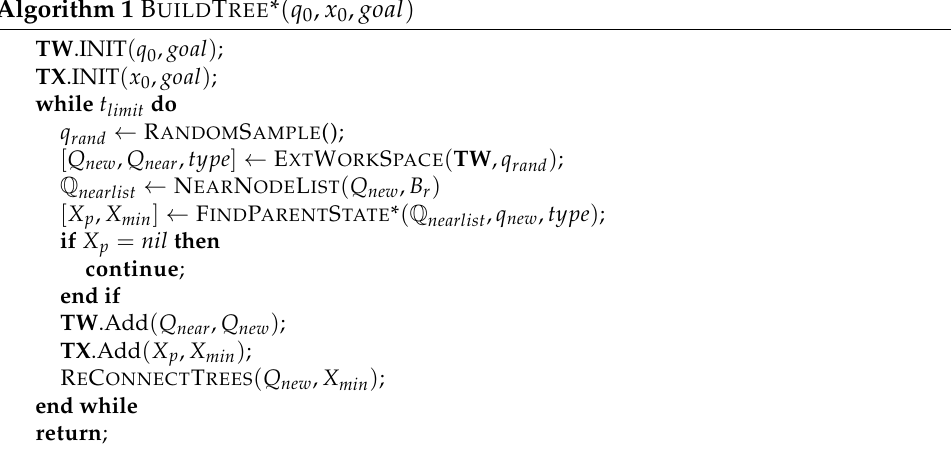
Figure 3. Finding parent node process in tree expansion. Algorithm 1 B UILD T REE * ( q 0 , x 0 , goal